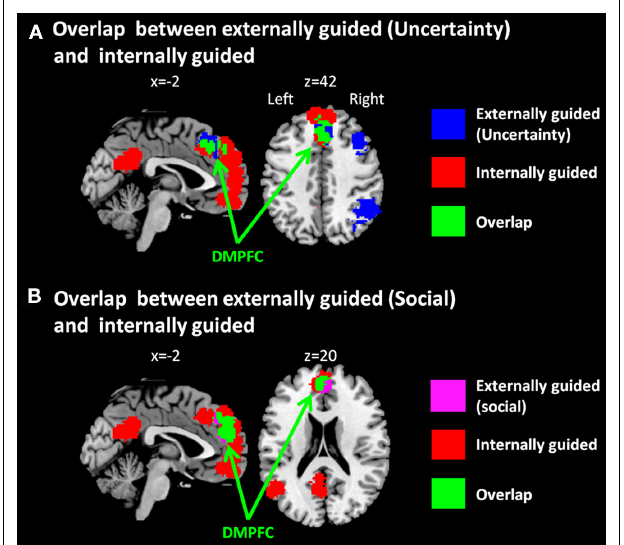
FIGURE 2 | Multi-level kernel density analysis results for overlaps (A) between externally guided decision-making under uncertainty and internally guided decision-making and (B) between externally guided decision-making in a social situation and internally guided decision-making. DMPFC, dorsomedial prefrontal